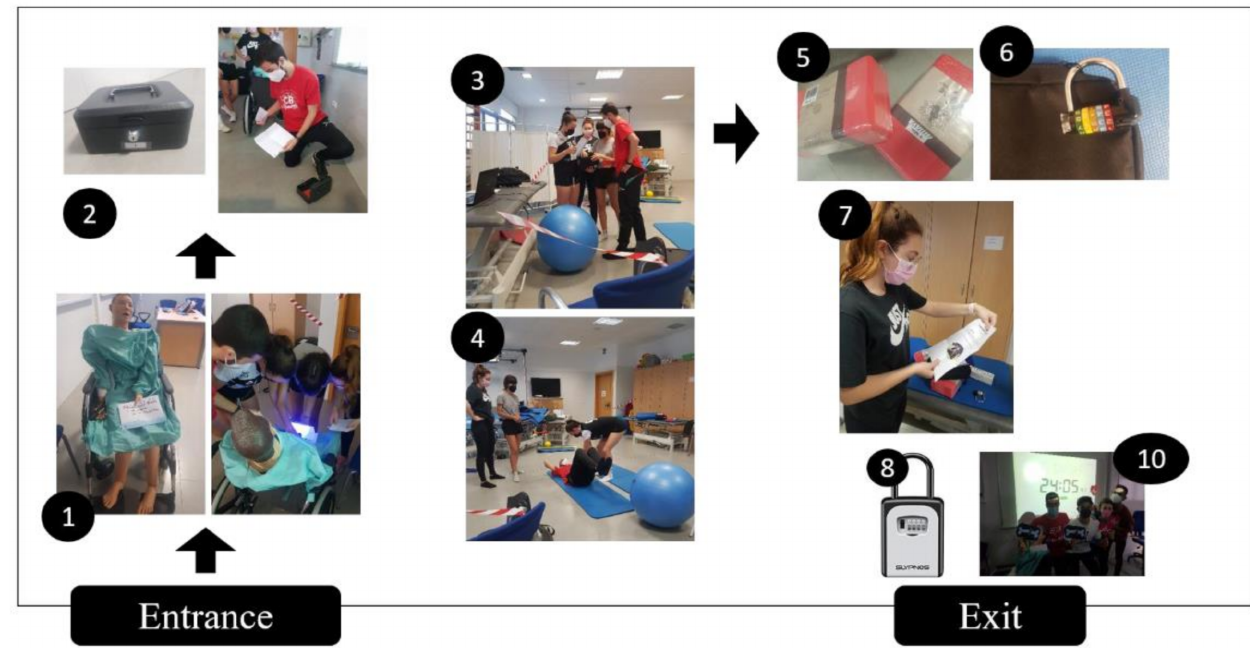
Figure 2. Escape room with physiotherapy